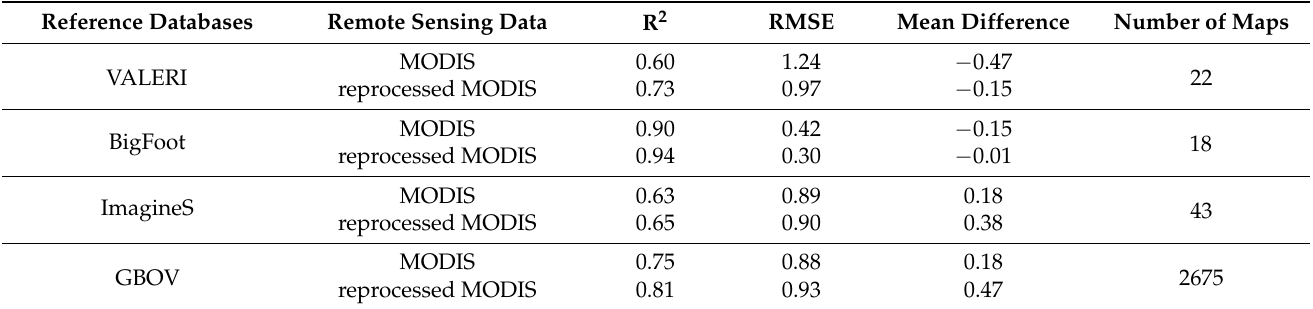
Table 2. Validation metrics of MCD15A2H C6.1 LAI product and reprocessed